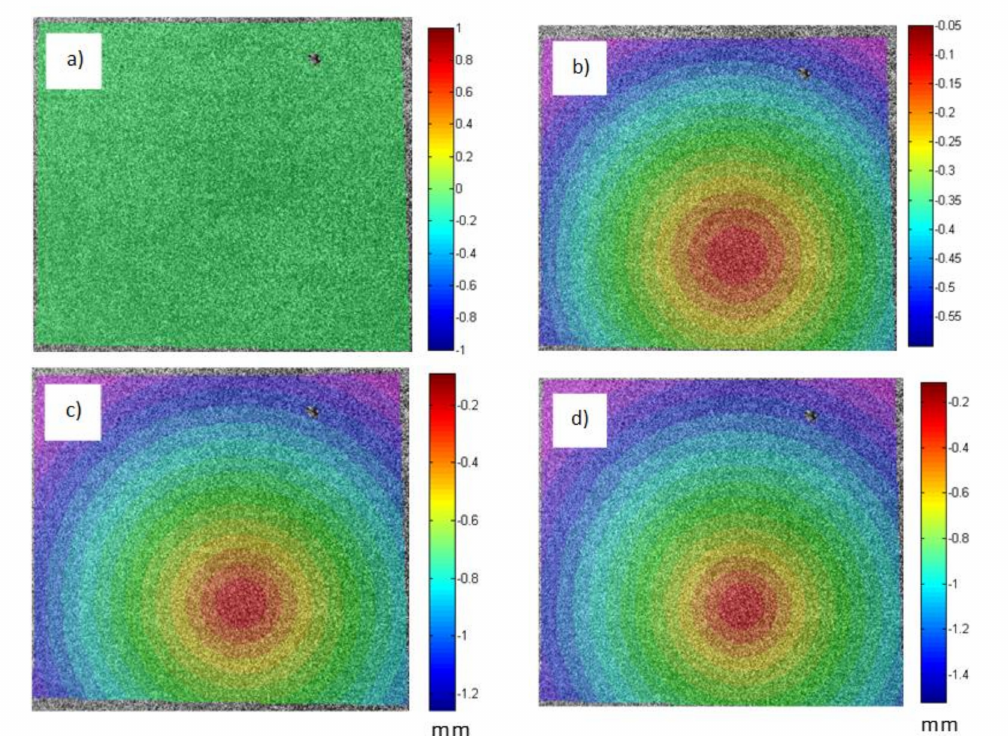
Figure 6. Out-of-plane displacements at the region of analysis when a 2 mm thick specimen is analysed at different loads: ( a ) 0 mm and 0 N; ( b ) − 0.05 mm and 320 N; ( c ) − 0.096 mm and 611 N; ( d ) − 0.111 mm and 731